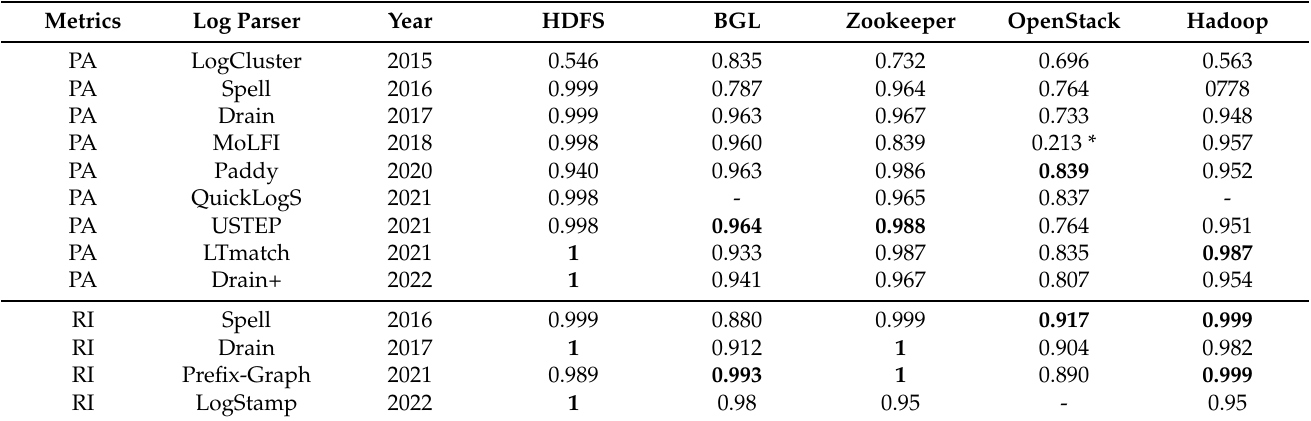
Table 1. Accuracy of some log parsing methods mentioned in this